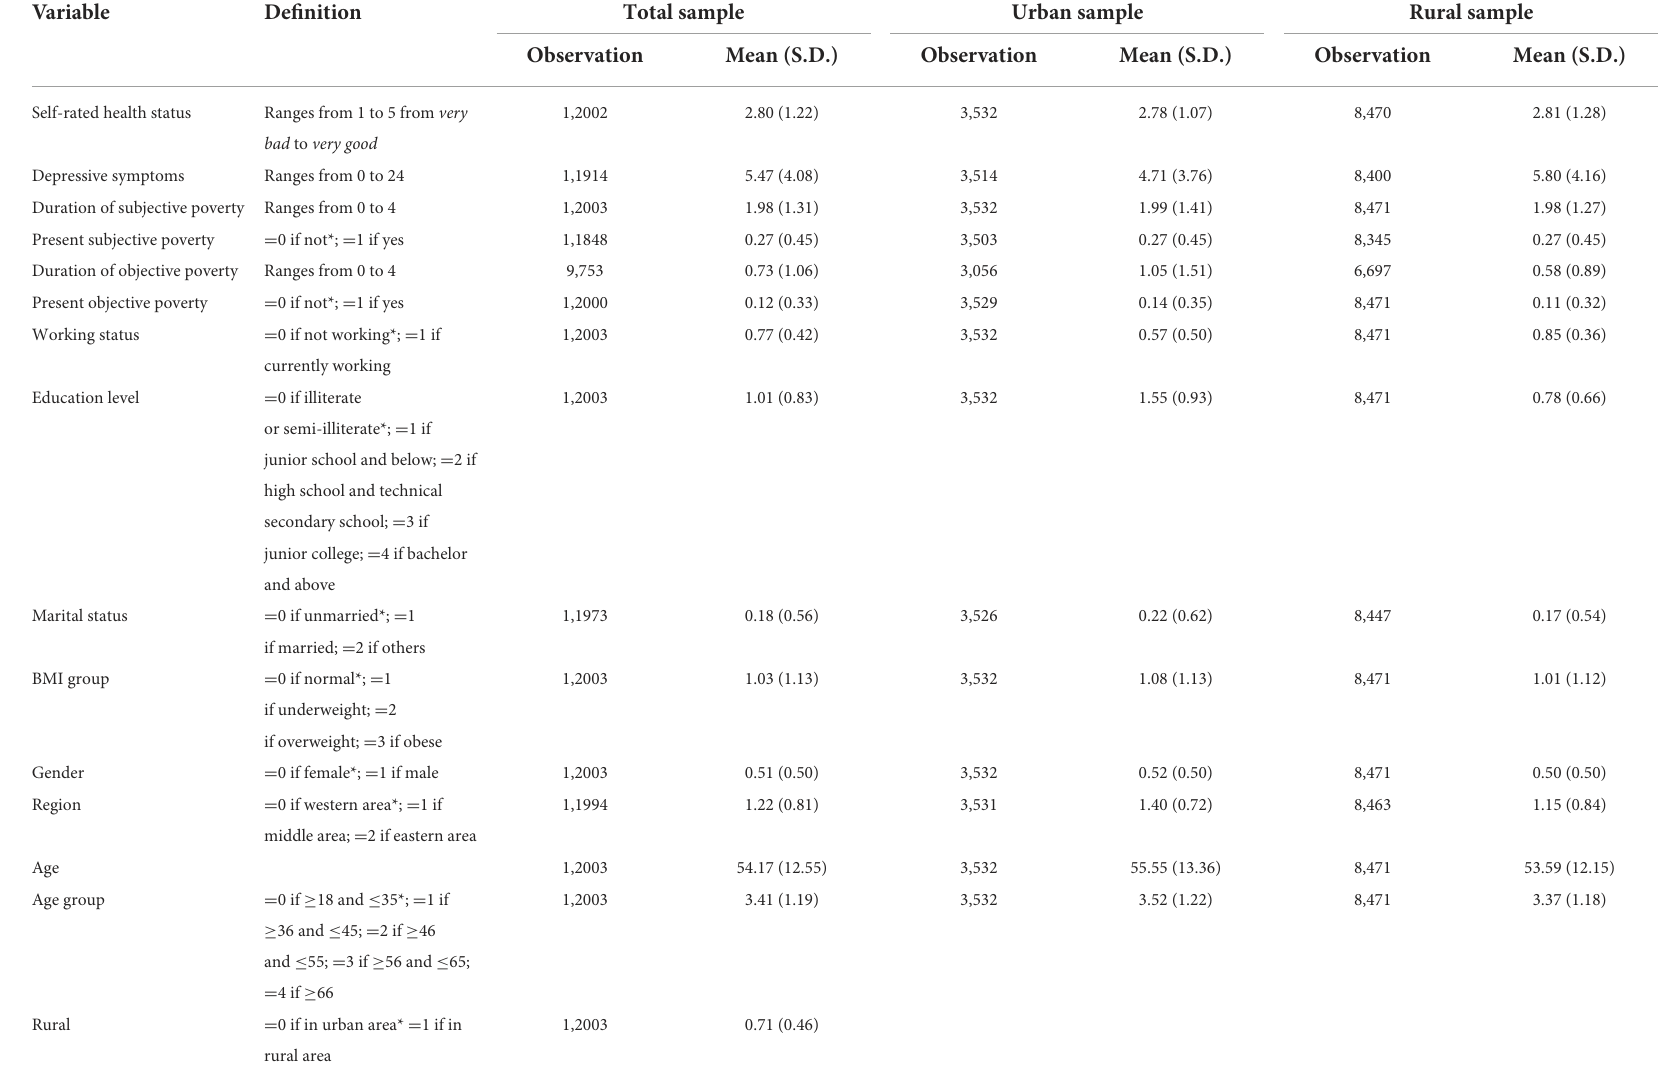
TABLE 1 Characteristics in